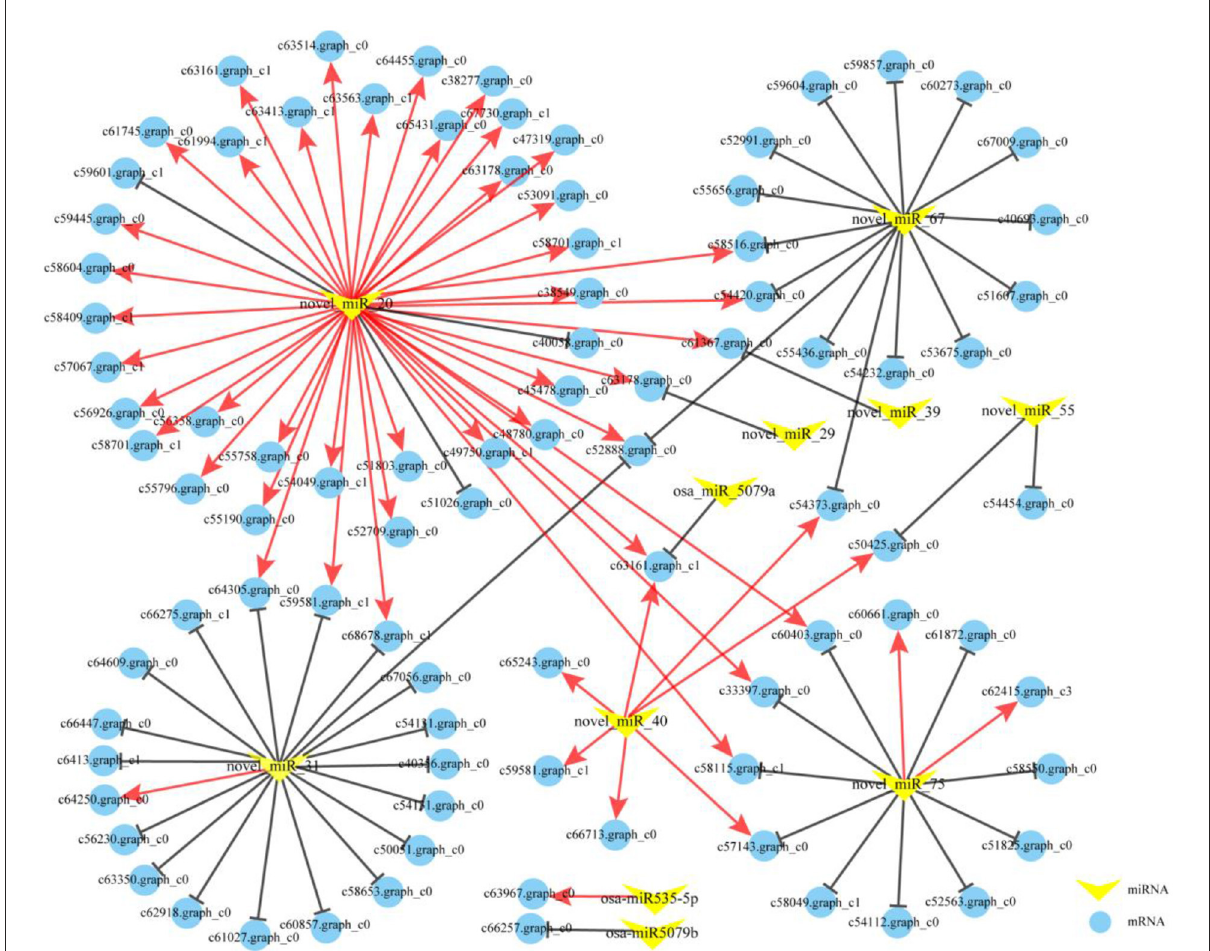
FIGURE8 The miRNA-mRNA interaction networks in the greening process of P. vivax . The networks were formed from 103 miRNA-mRNA pairs comprising, 11 DEMs (yellow V-shape), and 83 DEGs (blue circle). The red and black solid lines respectively, indicate coherent and non-coherent miRNA-mRNA pairs via in silico and degradome